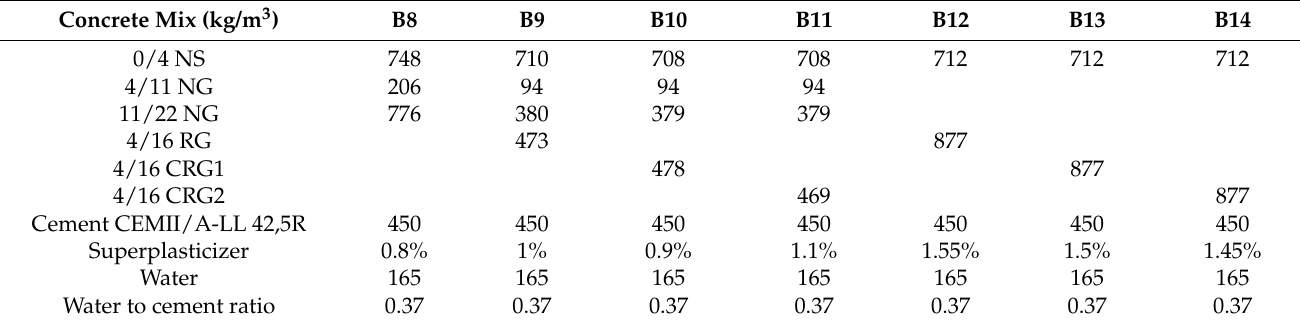
Table 5. Composition of the 7 C45 concretes (mass